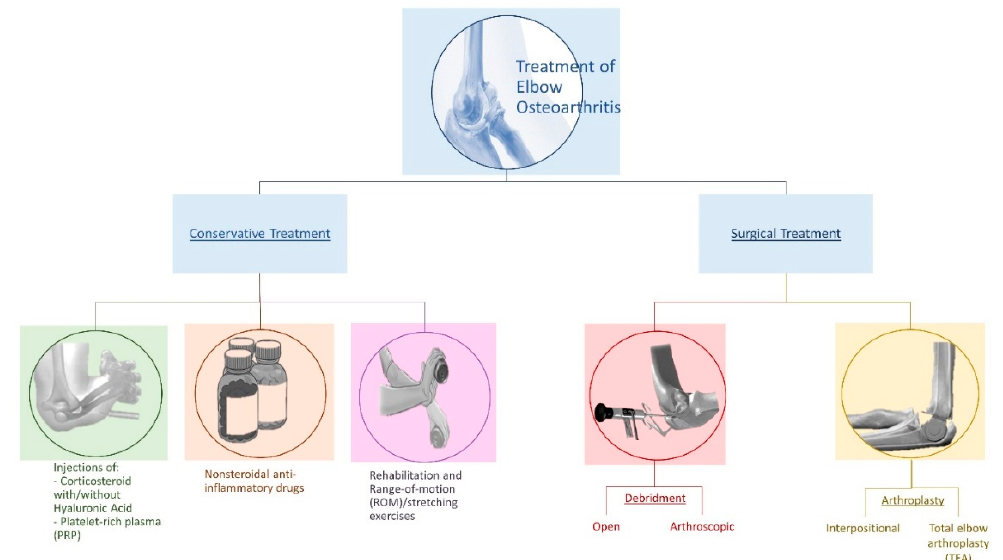
Figure 4. Main treatment approaches for elbow osteoarthritis.